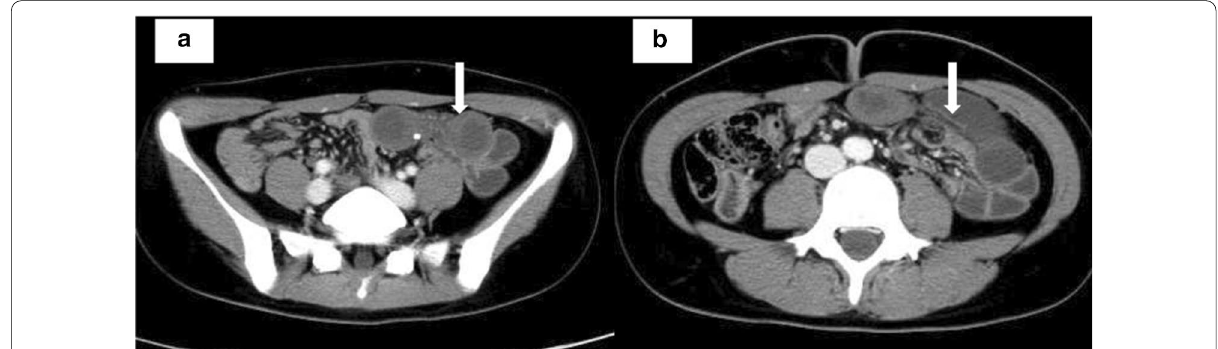
Fig. 1 Contrast-enhanced CT findings. Contrast-enhanced CT revealed submucosal edema of the intestinal wall (arrow) and a sustained contrast effect ( a ). A whirl sign (arrow) was present, and strangulated small bowel obstruction was suspected ( b